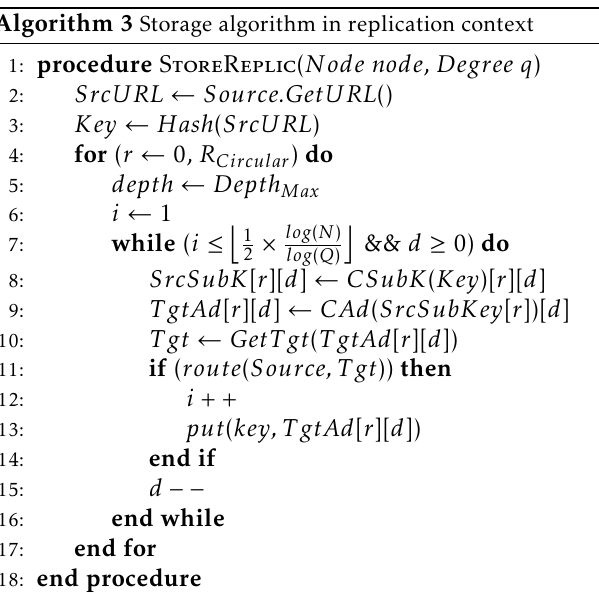
Algorithm 3 Storage algorithm in replication